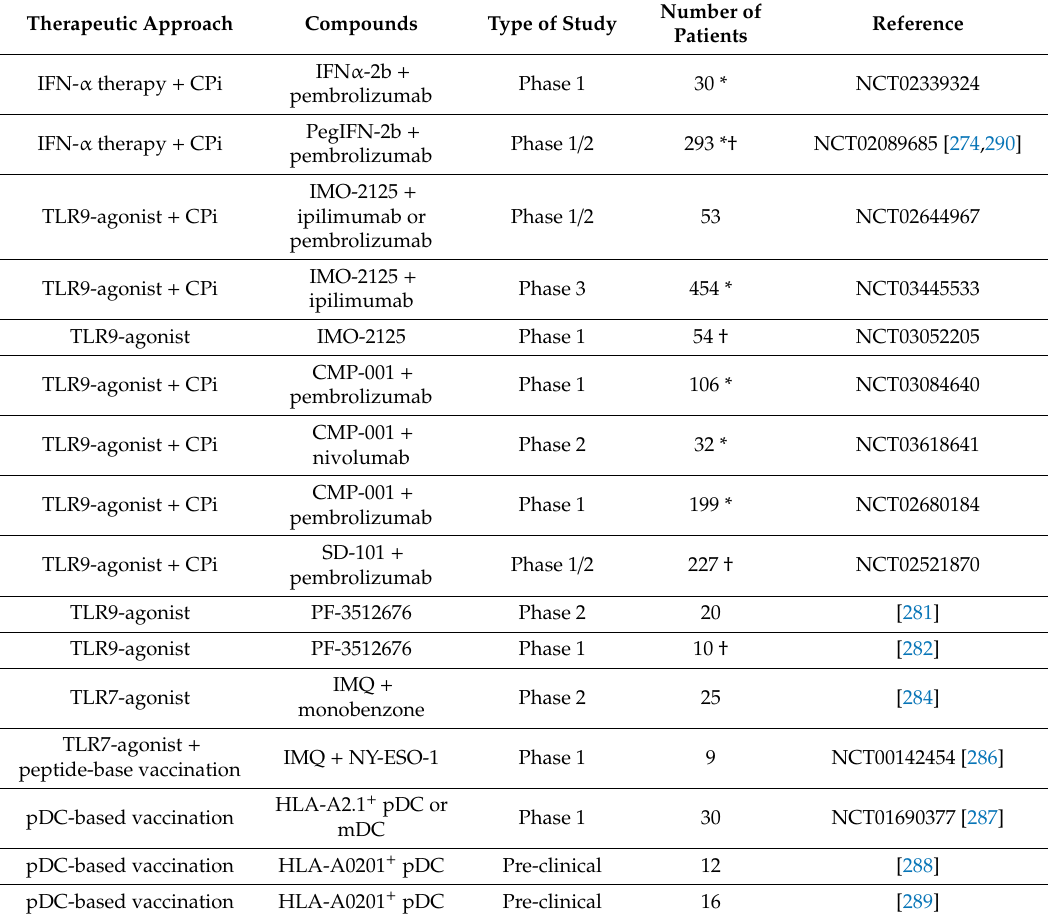
Table 2. Therapeutic approaches using pDCs in melanoma